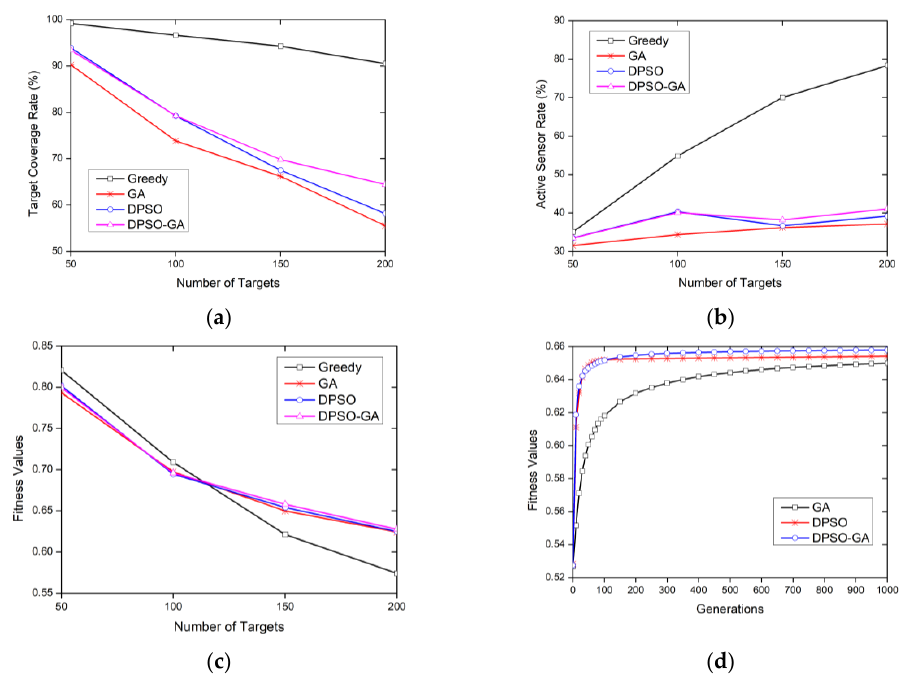
Figure 5. Effect of the number of targets on the target coverage rate, active sensor rate, and fitness values under the greedy, GA, DPSO, and DPSO_GA algorithms. ( a ) Target coverage rate, ( b ) active sensor rate, ( c ) fitness values, and ( d ) fitness values versus number of generations for the GA, DPSO, and DPSO_GA algorithms.